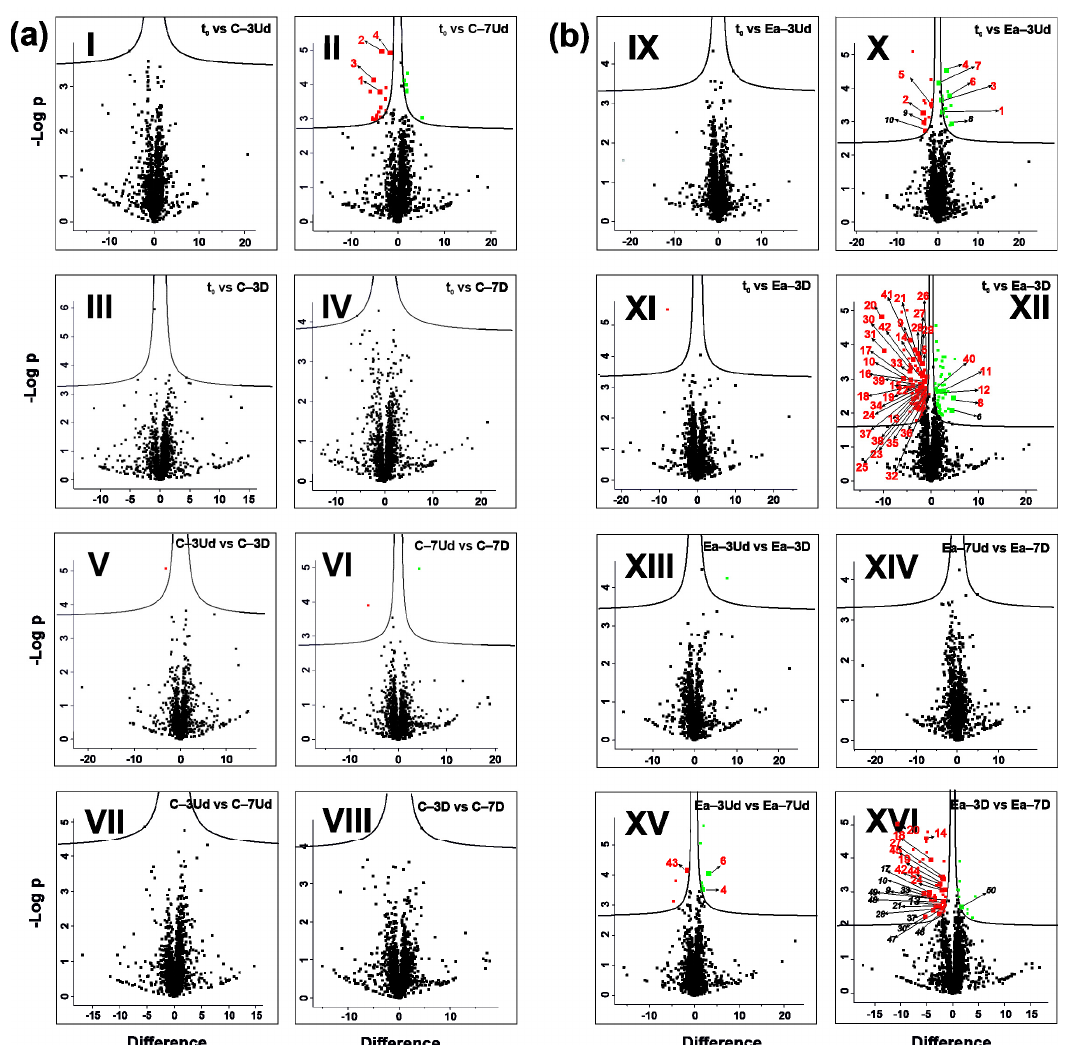
Figure 5. Volcano plots representing differentially abundant compounds identified in cotyledons ( a ) and embryonic axes ( b ) according to T test analyses between analyzed treatments ( p < 0.05). Partic- ular pairwise compared treatments are visualized in Panels I–XVI. Black points indicate compounds with similar abundance between compared treatments. Green points indicate less abundant com- pounds, whereas red points reflect more abundant compounds detected in stored seeds compared to nonstored seeds (Panels I–IV and IX–XII), in damaged seeds compared to undamaged seeds stored at a particular temperature (Panels V–VI and XIII–XIV) and in seeds stored at − 7 ◦ C compared to seeds stored at − 3 ◦ C (Panels VII–VIII and XV and XVI). Bolded points indicate differentially abundant compounds with the identified molecular formula (numbered 1–49, listed in Table S1, quantified in Supplementary File). Italicized numbers imply identified compounds selected according to localization on volcano plots but not indicated according to T